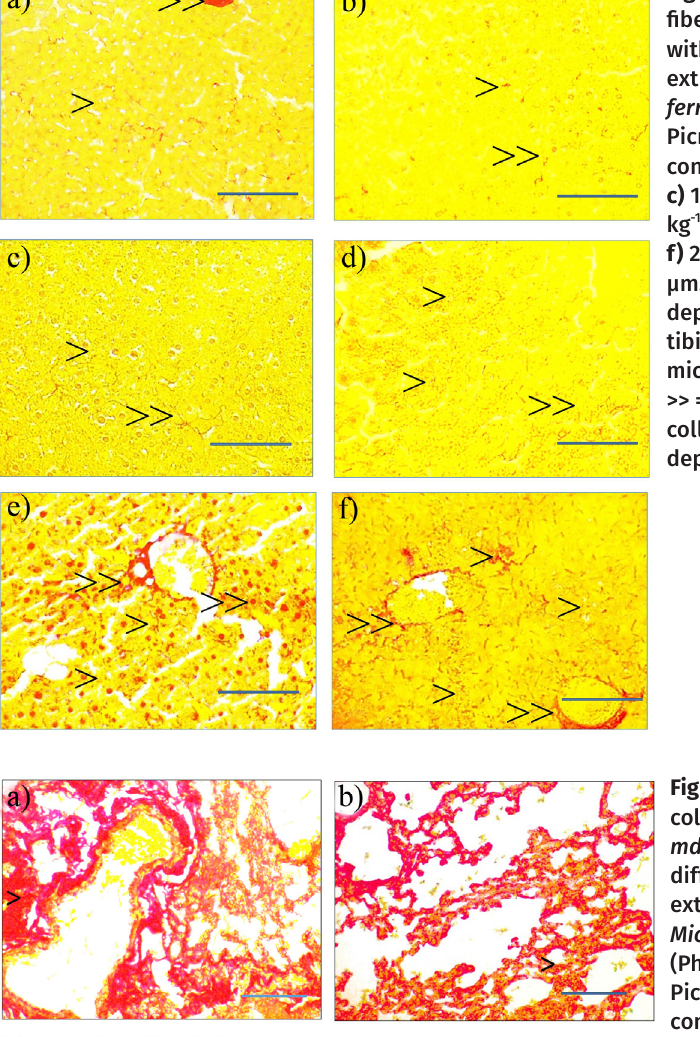
Figure 9. Distribution of collagen fibers in lung of mdx mice treated with different doses of aqueous extract from leaves of Miconia ferruginata (Photomicrography, Picrosirius Red staining). a) control group; b) 50 mg kg -1 group; c) 100 mg kg -1 group; d) 200 mg kg -1 group; e) 300 mg kg -1 group; f) 2000 mg kg -1 group. Bar: 400 µm. > = Deposition of collagen fibers in pulmonary parenchyma.